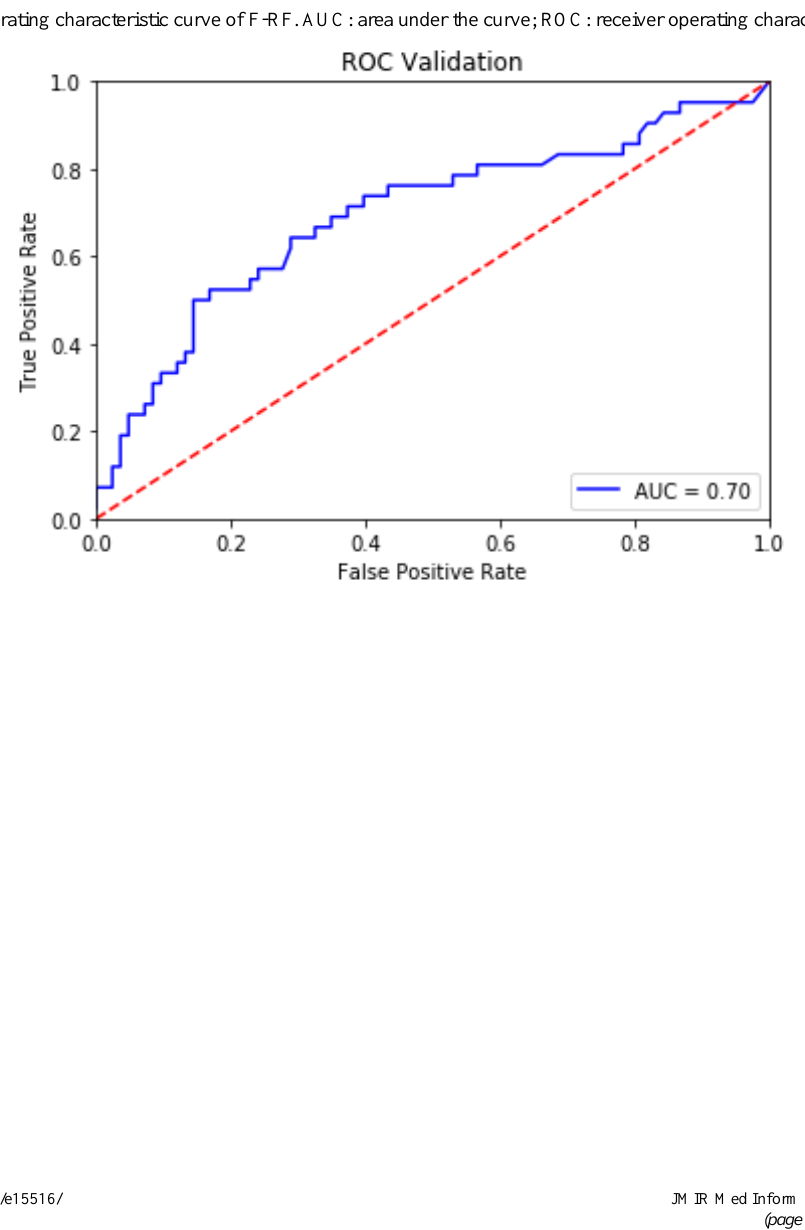
Figure 4. The receiver operating characteristic curve of F-RF. AUC: area under the curve; ROC: receiver operating